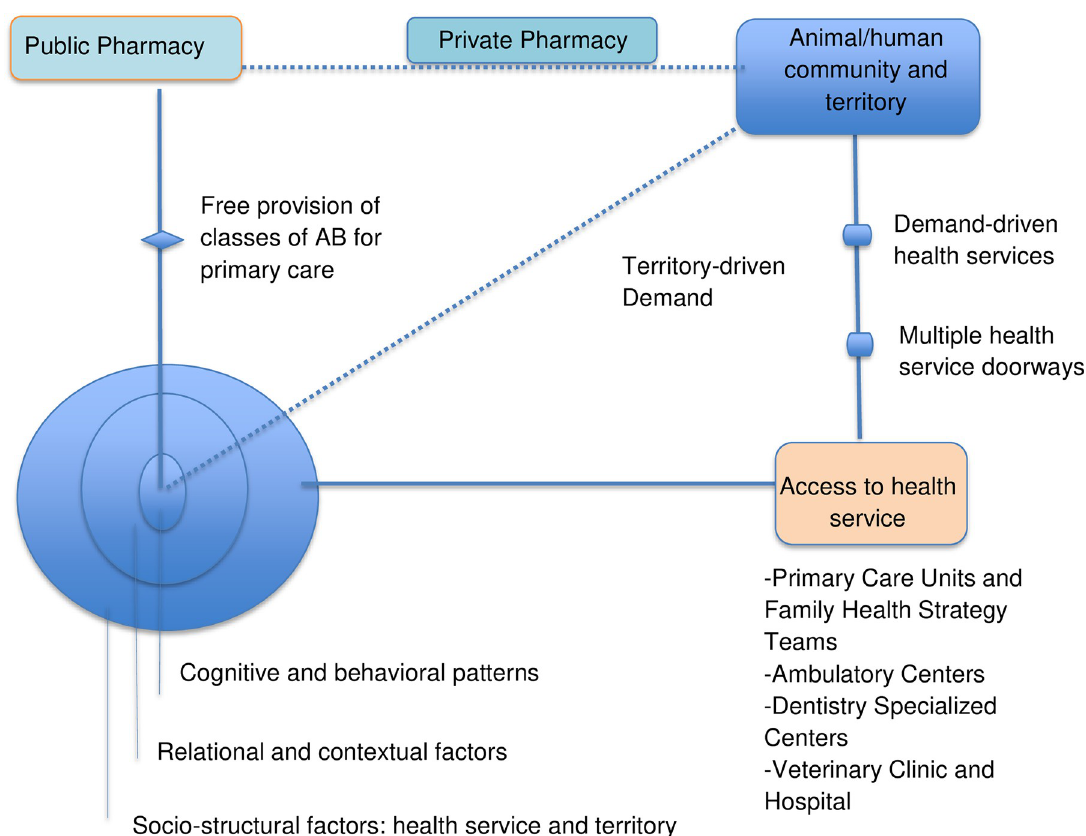
Fig 1. Diagram of in-locus overlapping factors informing prescribing and dispensing practices in primary care. This diagram presents all major health settings that are available for human and animal patients in primary care, including the community and territorial demands for health units. In S ã o Paulo, human medicine disposal procedures, vaccination and epidemiological surveillance are also activities PCUs oversee in their coverage area. Accessing the health service, both the human and animal sectors patients are sent to AB prescribers without sorting their needs. Public pharmacies for human health provide only essential medications, including classes of AB, as part of a national and local intervention, controlling the availability of ABs for patients in public services. Medications unavailable in the public pharmacy may be purchased in private pharmacies or veterinary clinics and stores. There are several types of services for human health in primary and secondary health care levels in the community; in certain cases, patients may be confused regarding the service most appropriate for